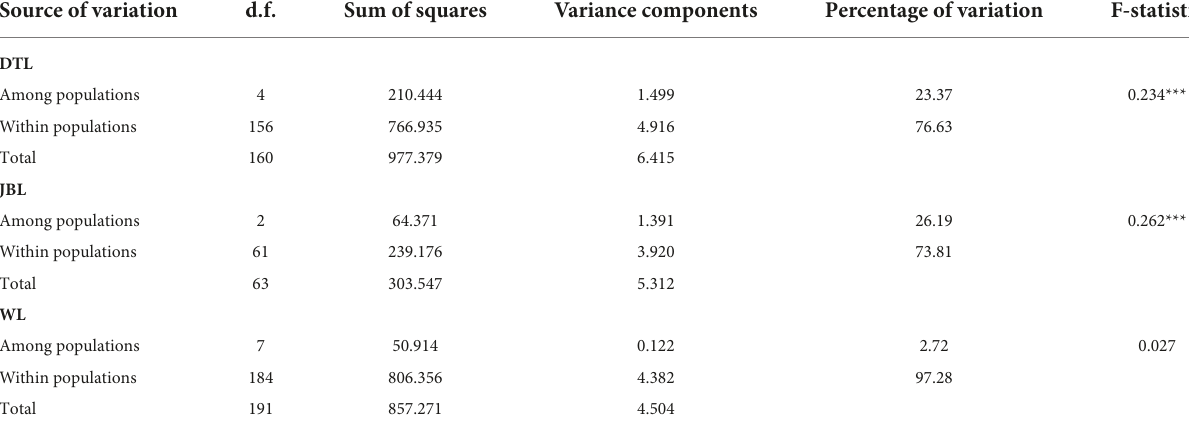
TABLE 4 Analysis of molecular variance (AMOVA) of Daotian carp (DTL), Jinbian carp (JBL), and Wu carp (WL). Source of